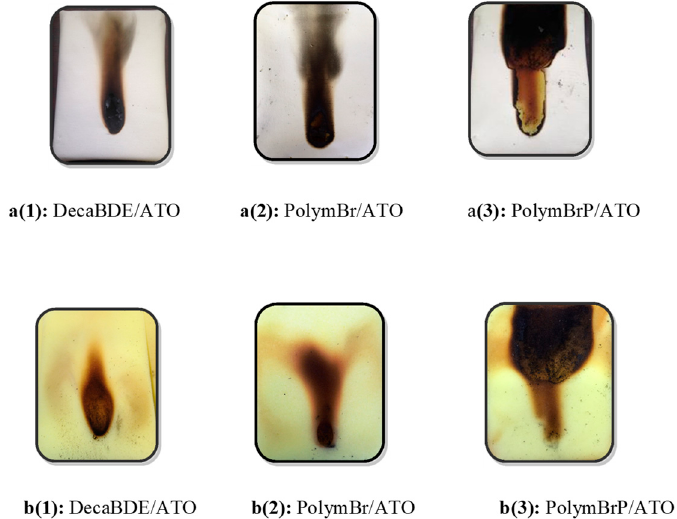
Figure 3. Simulated “match” samples at the “pass” condition; ( a ) fabric and ( b ) foam damaged areas [45].